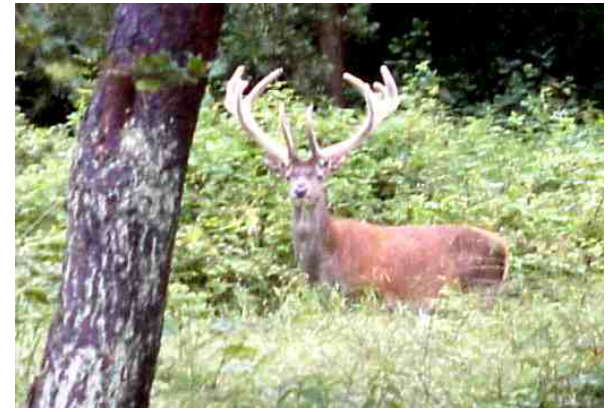
Figure 29. Wildlife inside of the sheltered station compound.